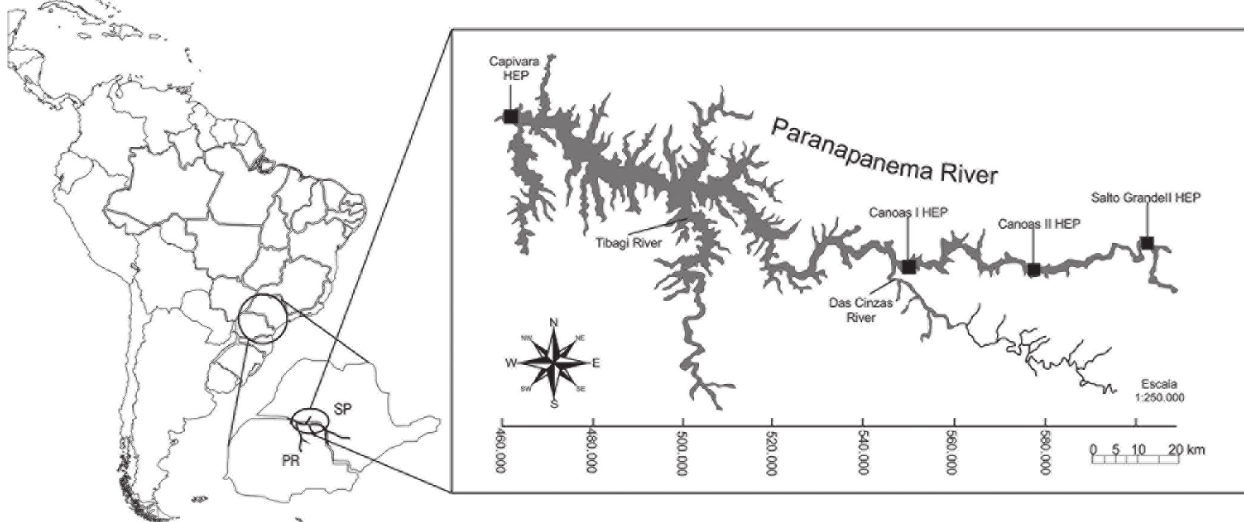
Fig. 1. Partial view of the Parapanema River and its principal affluents (Tibagi and das Cinzas Rivers). Featured are the two collection sites: HEP Canoas I and Canoas II.